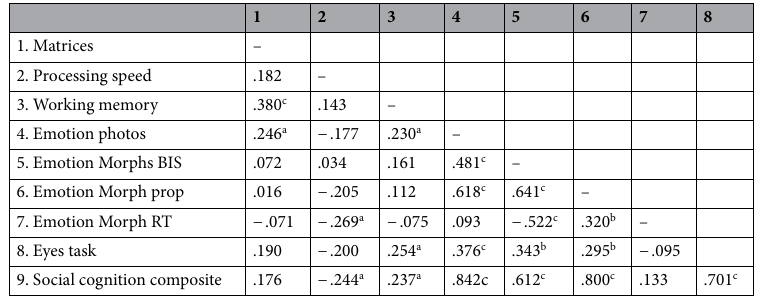
Table 3. Partial correlations between main variables after controlling for age over all participants. Emotion Morph BIS: Balanced Integration Score. Emotion Morph Prop: Proportion correct. Emotion Morph RT: